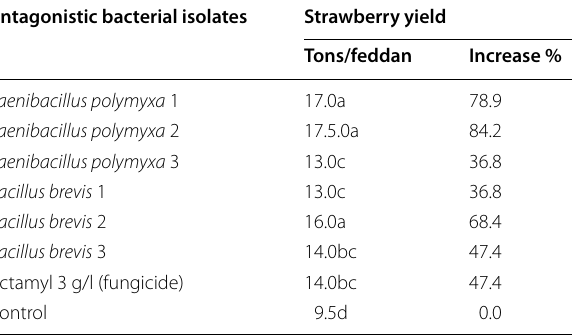
*Means in a column followed by the same letter are not significantly ( P different according to